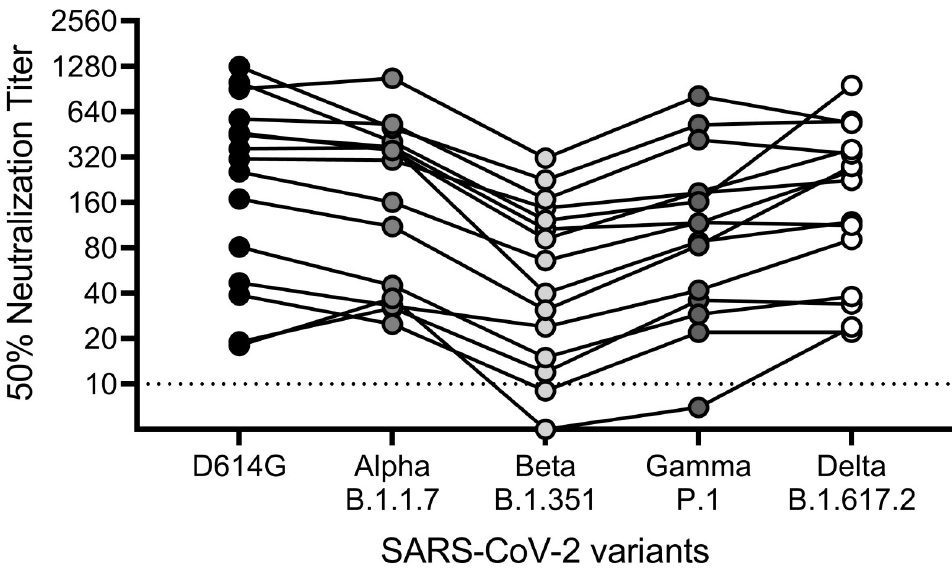
Fig 8. Virus neutralization of SARS-CoV-2 variants of concern. Virus neutralization titers for SARS-CoV-2 convalescent sera against four SARS-CoV-2 variants of concern–Alpha (B.1.1.7), Beta (B.1.351), Gamma (P.1) and Delta (B.1.617.2)–relative to an early pandemic strain (D614G). The comparison between strain variants was done on the same day using a single dilution for each serum sample. ELISA primary antibody: mouse mAb